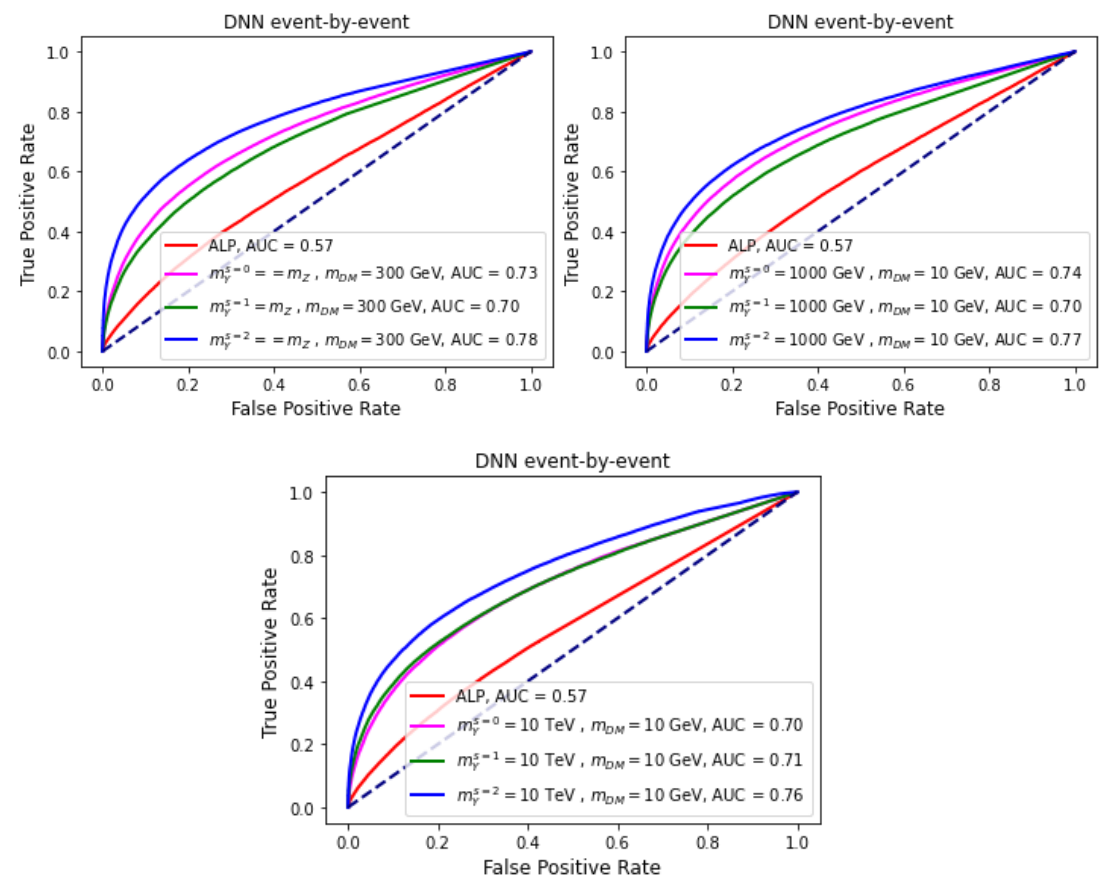
Figure 5: ROC curves for new physics benchmark models vs SM background, using DNN and event-by-event